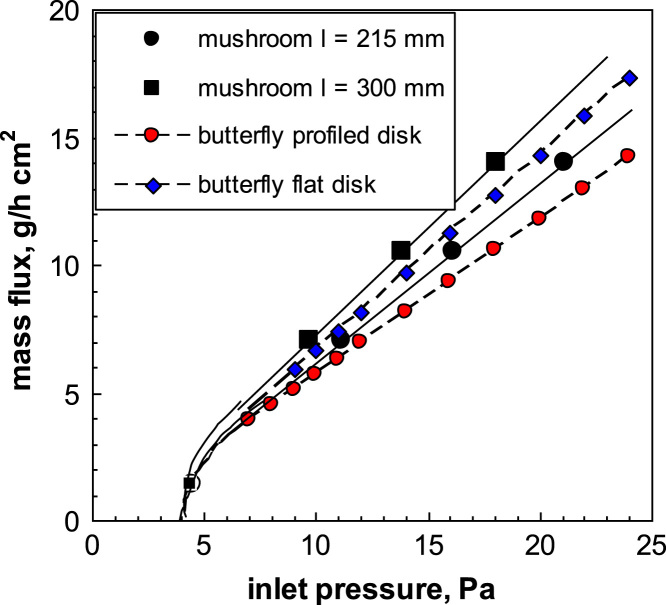
Comparison of mushroom and butterfly valve conductance; Pout=4 Pa.